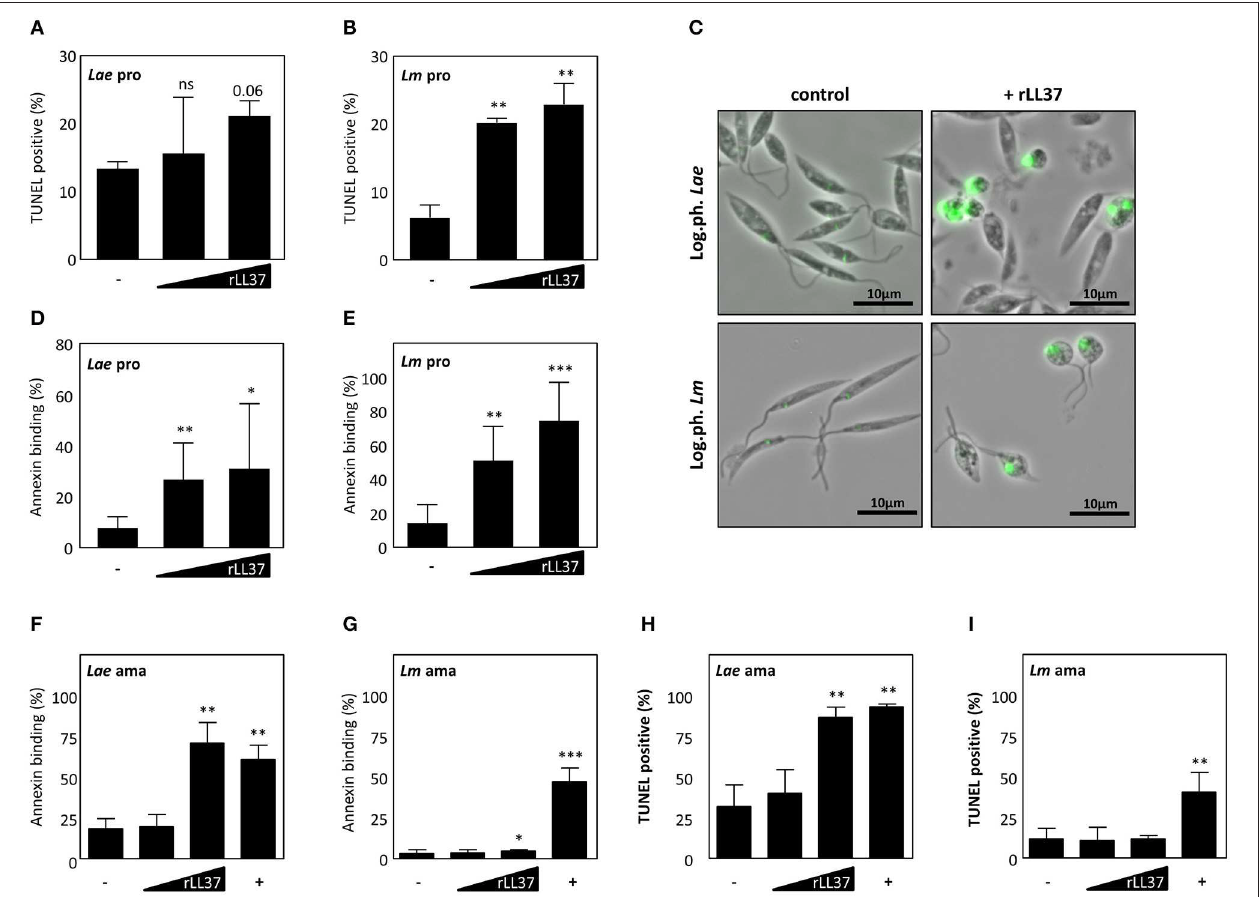
FIGURE 2 | Dose dependent killing of Leishmania by human recombinant LL-37. Both logarithmic phase Lm and Lae promastigotes and axenic amastigotes were treated with different concentrations of rLL-37 or 25 µ M staurosporine ( + ). After 24–72h, DNA fragmentation was assessed by flow cytometry (A,B) for Lae and Lm promastigotes, respectively, and microscopy (C) and for Lae and Lm amastigotes (H,I) . Using flow cytometry Annexin binding was assessed by promastigotes (D,E) and axenic amastigotes (F,G) from Lae and Lm, respectively. Data are presented as mean ± SD of at least 3 independent experiments (paired t -test; * p < 0.05; ** p < 0.01; *** p < 0.001; ns, not significant; pro, promastigotes; ama,